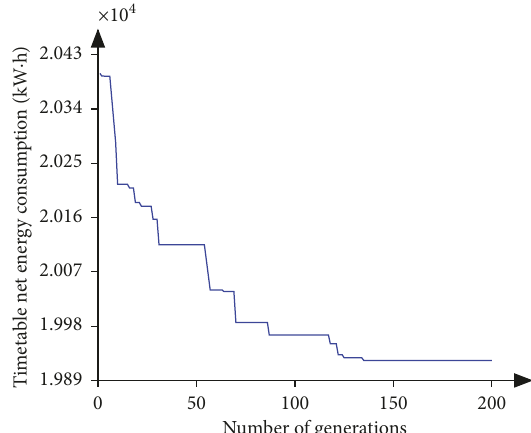
Figure 7: Iterative process finding the optimal total energy con- sumption value of the